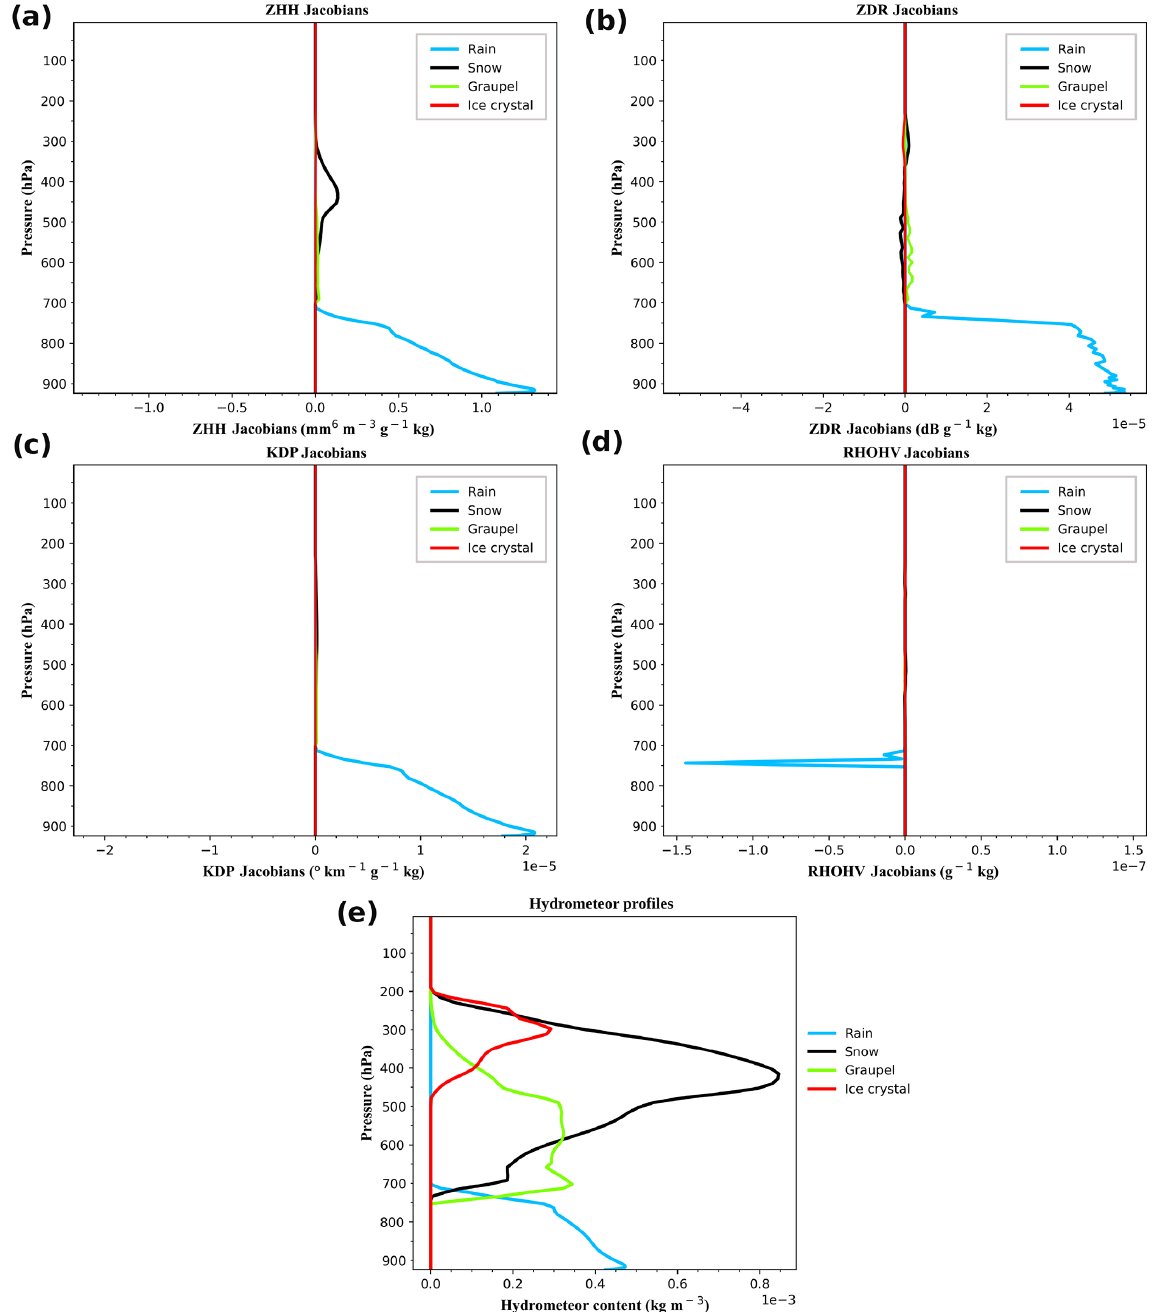
Figure 10. (a) Z HH Jacobians, (b) Z DR Jacobians, (c) K DP Jacobians and (d) ρ HV Jacobians; (e) represents hydrometeor content profiles, associated with a convective event which struck the Hérault and Gard departments on the 19 October 2017 06:00TU. The Jacobians presented here are normalized by 10% of the hydrometeor contents.